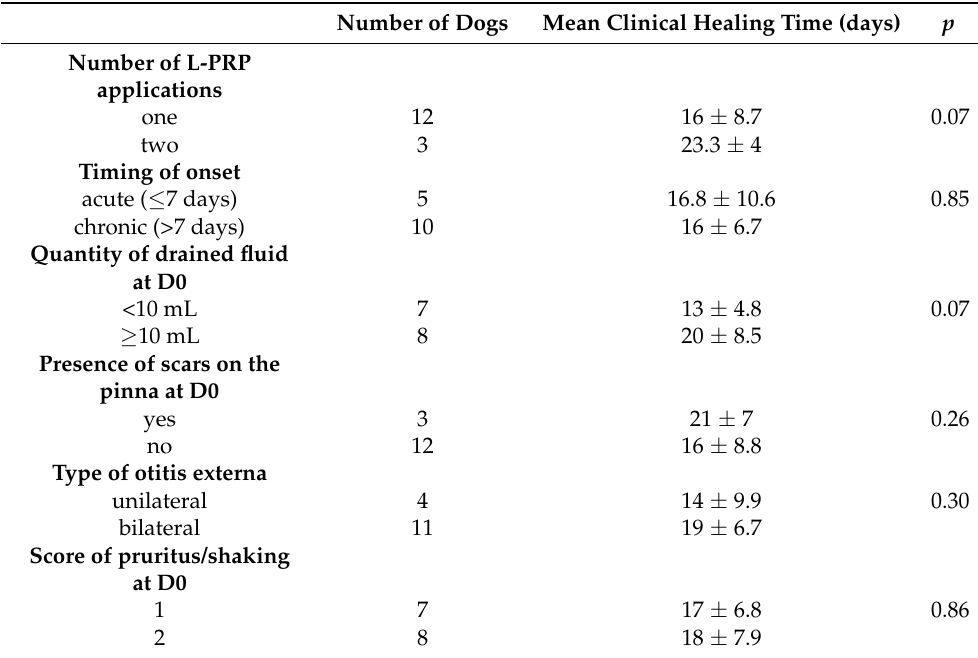
Table 4. Correlation between clinical variables and mean healing times in 15 dogs that completed the clinical